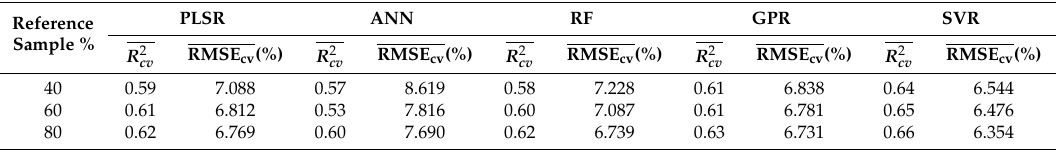
Table 7. The accuracy for PLSR, ANN, GPR, SVR, and RF with nine bands and four mean textures as input variables for CRC estimation using varying percentages of the total samples ( n =